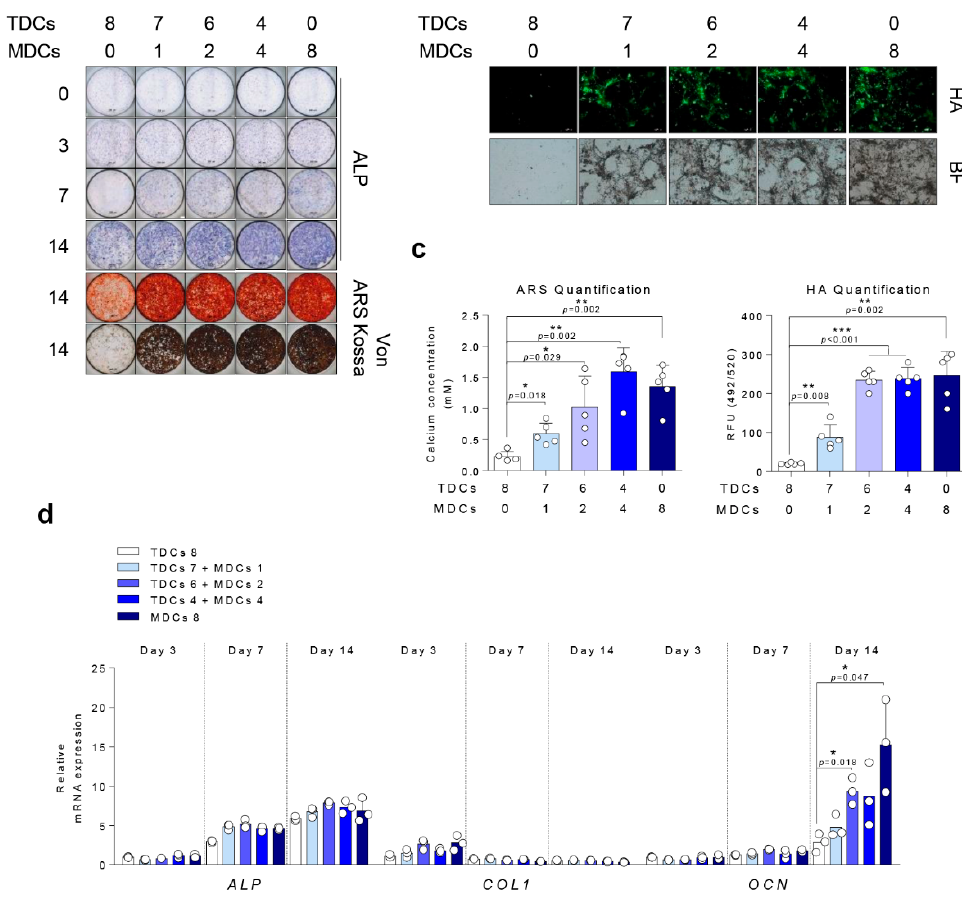
Figure 3. MDCs-enhanced bone mineralization of TDCs in response to osteogenic differentiation. A total of 8 × 10 3 cells/well (tendon and/or muscle cells, as indicated) were cultured in osteogenic media for the indicated number of days and assessed by ( a ) ALP, ARS, and Von Kossa staining (scale bar = 200 µm) and ( b ) HA staining (scale bar = 500 µm). ( c ) Quantification of ARS and HA staining. ( d ) A total of 8 × 10 4 cells (TDCs and/or MDCs, as indicated) were cultured in osteogenic media for the indicated number of days and analyzed by qPCR for differentiation markers. *, p < 0.05; **, p < 0.01; ***, p <0.001. Data are presented as the mean ± SEM.